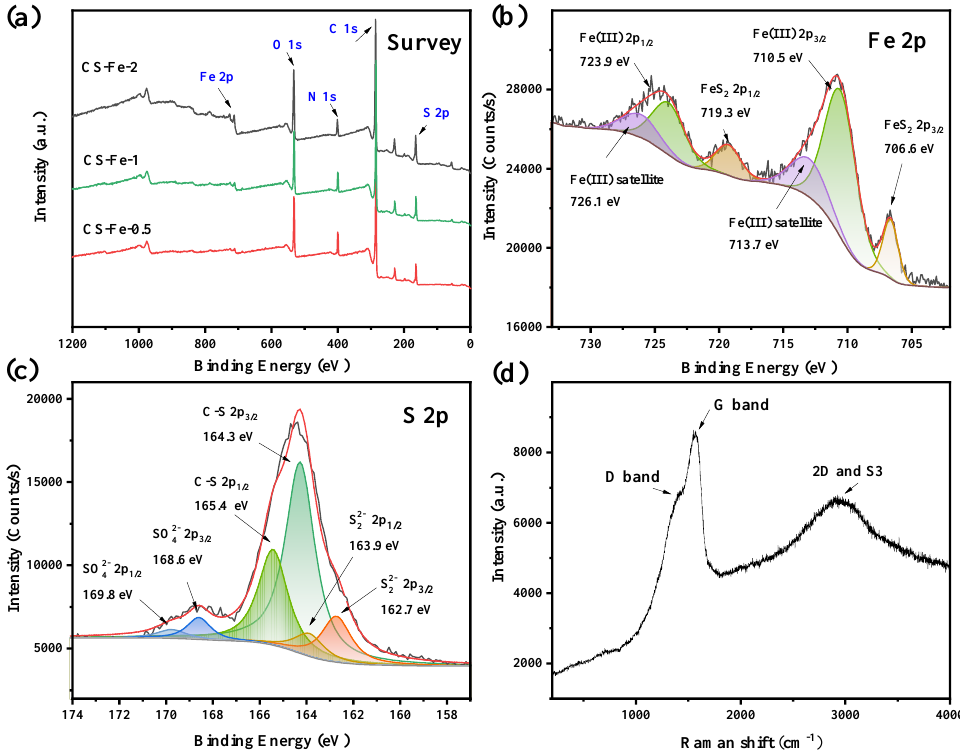
Figure 3. ( a ) XPS survey spectra of the prepared samples; ( b ) Fe 2p spectra of CS-Fe-2; ( c ) S 2p spec- tra of CS-Fe-2; ( d ) Raman spectra of CS-Fe-2. According to Table S1, the surface carbon contents of CS-Fe-2 reached 64.93 at%. The Raman spectra in Figure 3d showed a relatively strong G band at 1574 cm − 1 , a broad S3 band at 2923 cm −1 , and a weak D band at about 1370 cm −1 , implying the presence of a multilayered graphene structure with many defects [33]. The deconvoluted C 1s and N 1s spectra in Figure S1 revealed the existence of a few oxygen atoms but many nitrogen- containing functional groups bonded to the carbon skeleton. Consequently, as shown in the elemental mapping (Figure 4), the distribution of N was consistent with that of C, while O was more similar to Fe due to surface FeS 2 oxidation.